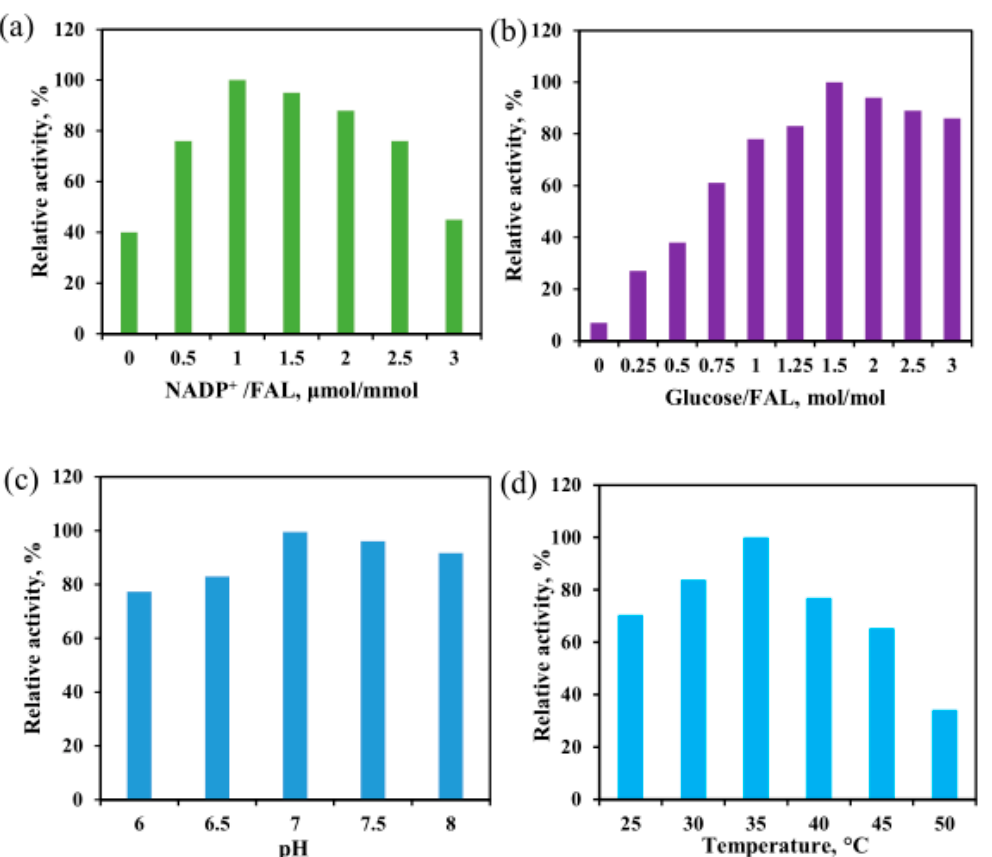
Figure 10. Effects of NADP + load (NADP + /FAL 0–3 μ mol/mmol, pH 7.0, temperature 35 °C, co-substrate glucose/FAL 1.5 mol/mol) ( a ), co-substrate glucose load (glucose/FAL 0–3 mol/mol, pH 7.0, temperature 35 °C, NADP + /FAL 1 μ mol/mmol) ( b ), medium pH (6–8) (temperature 35 °C, glucose/FAL 1.5 mol/mol, NADP + /FAL 1 μ mol/mmol) ( c ), and bioreduction temperature (25–50 °C, pH 7.0, glucose/FAL 1.5 mol/mol, NADP + /FAL 1 μ mol/mmol) ( d ) on the FAL-reducing activity.